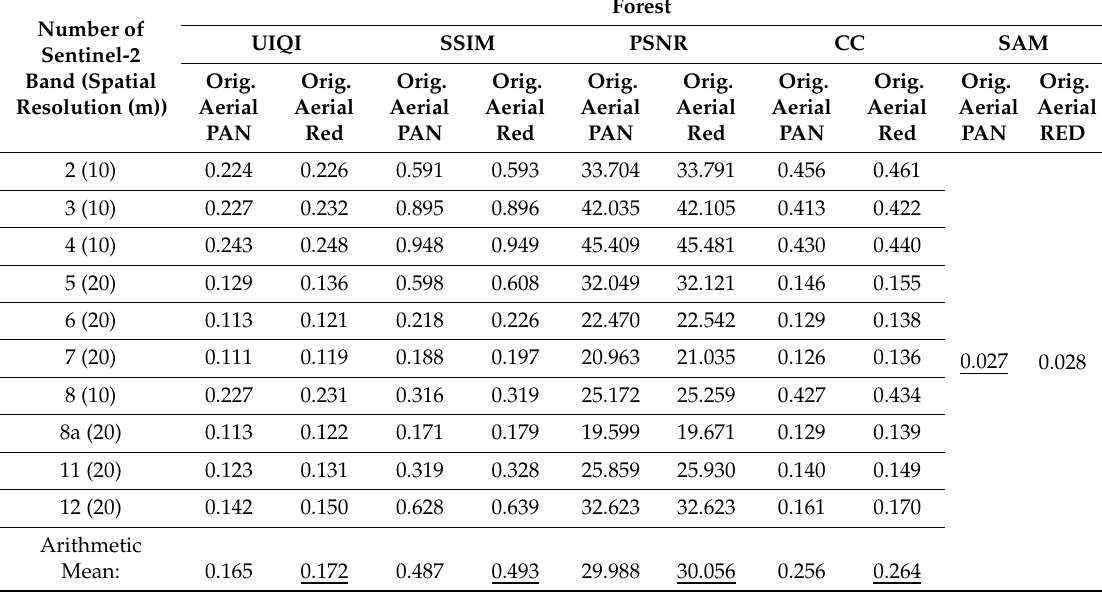
Table 2. Spectral quality values for the forest sample (the best results are underlined).